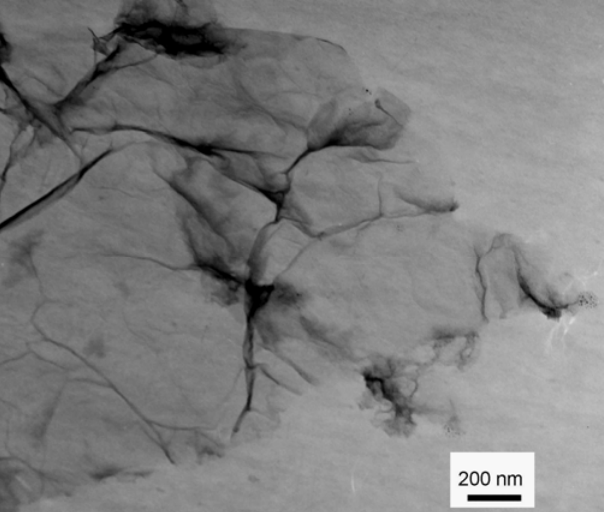
Figure 1. Transmission electron microscope (TEM) image of graphene oxide